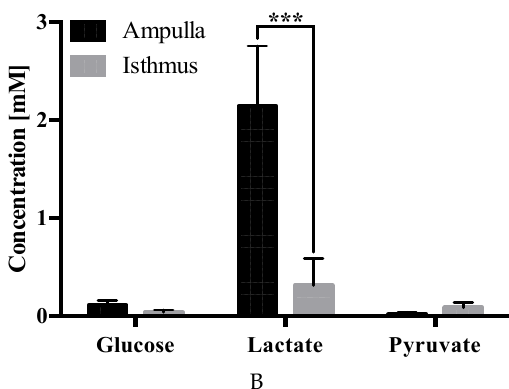
Figure 6. Carbohydrate concentrations (± SEM) in the ampullary vs. isthmic comparisons from ( A ) cyclic and ( B ) pregnant heifers–wherein *** p ≤ 0.001 and ** p ≤ 0.01.